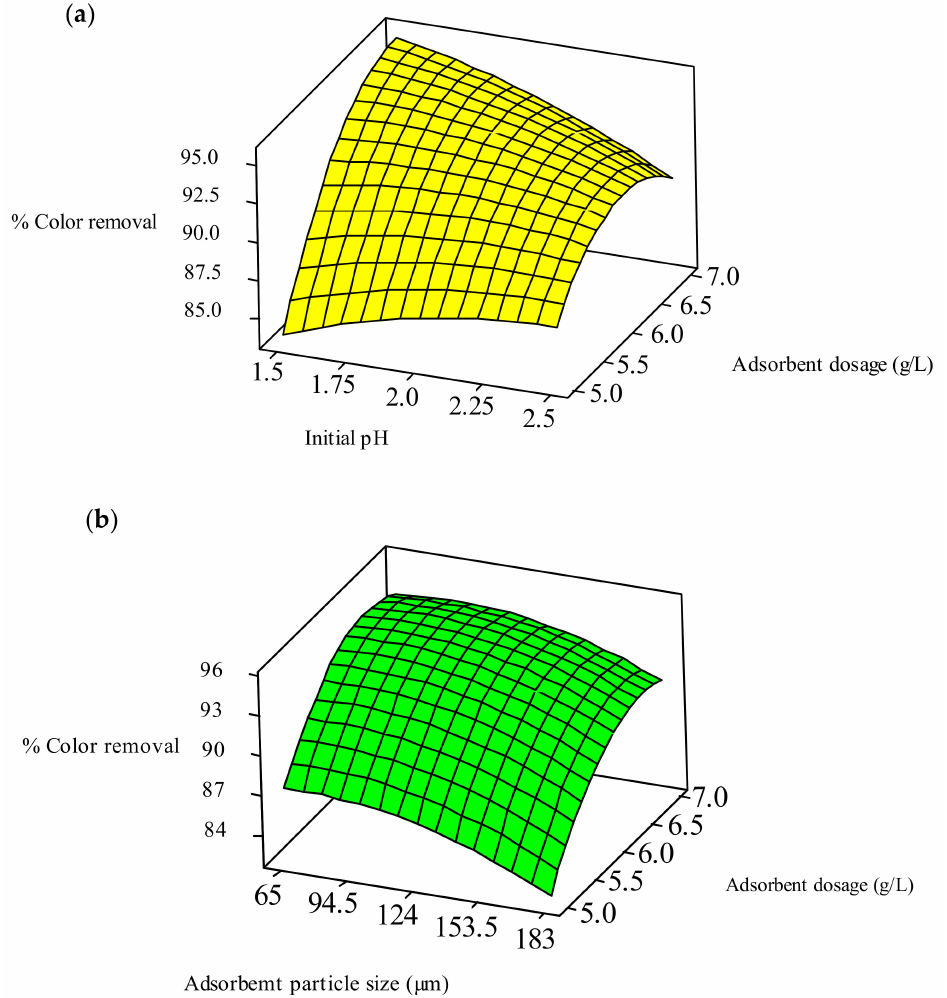
Figure 9. Response surface plots for the interactive effect of ( a ) adsorbent dosage and initial pH, and ( b ) adsorbent dosage and adsorbent particle size on decolorization of RBBR dye. Table 5. Validation of process model for % decolorization of RBBR. (Initial dye